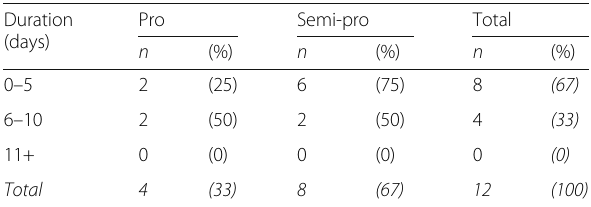
Table 2 Individuals to whom concussive symptoms were reported Physio Coach Teammate Doctor